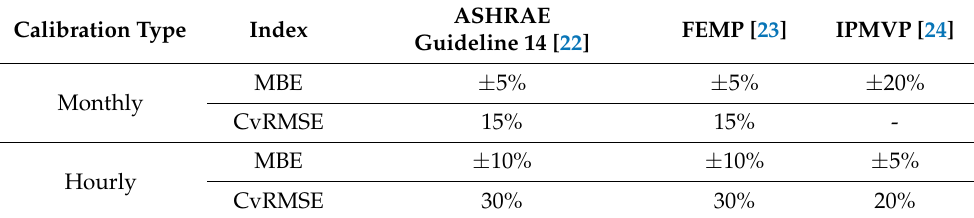
Table 2. Acceptable calibration tolerances in building energy performance prediction.